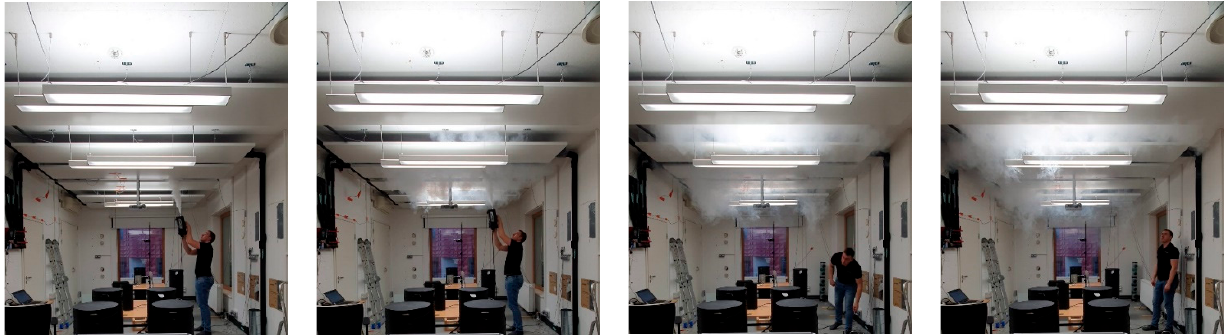
Figure 14. Air circulation pattern of ceiling panels HIGH. Periodic snapshots every 5 s.